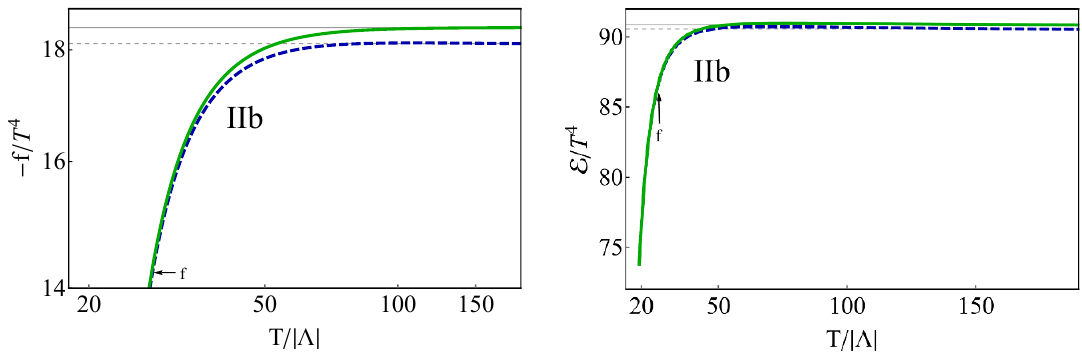
Figure 13 . Free energy (left) and energy density (right) versus temperature of the CFT 3 with a positive source (cid:3). Stable (metastable) states are shown in solid green (dashed blue). then increases, eventually diverging as (cid:30) ! (cid:30) (cid:0) (cid:3)